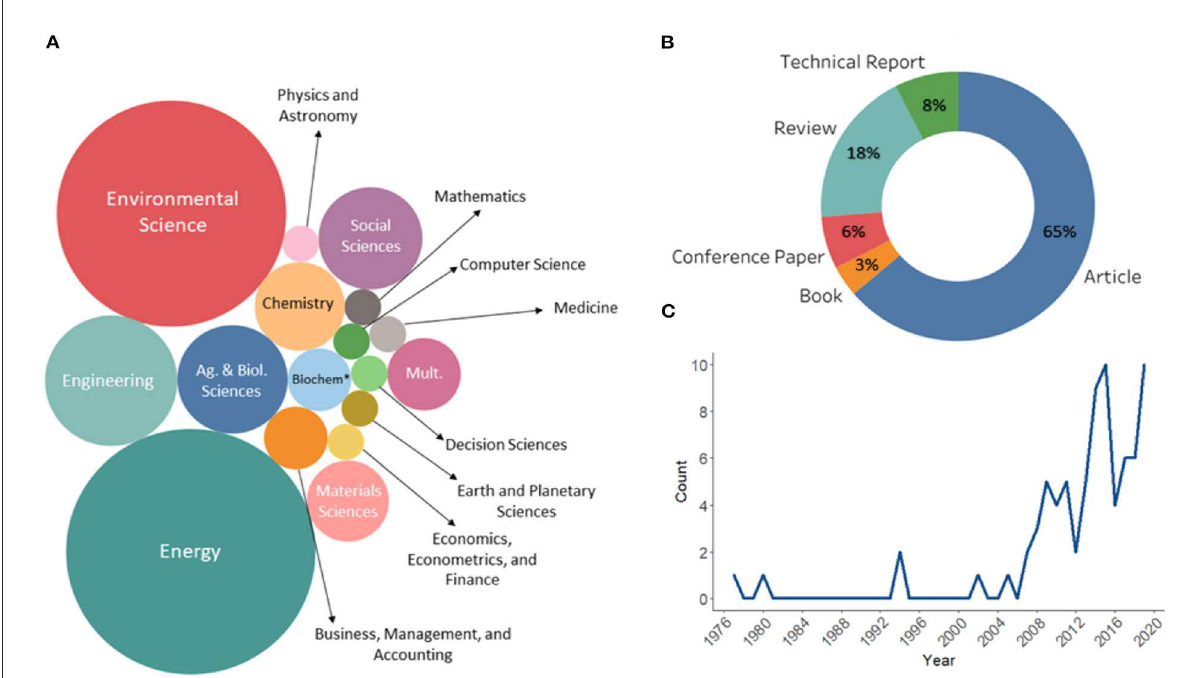
FIGURE2 Bibliometric attributes of articles using solar energy-land (SE-land) metrics, including: (A) subject areas of the articles as categorized by the SCOPUS database, where “mult.” represents multidisciplinary sciences and “biochem*” represents biochemistry; size of circle is relative to the frequency of use of SE-land metrics in a category; (B) percentage of studies by type of publication; and (C) publication frequency of SE-land metrics across